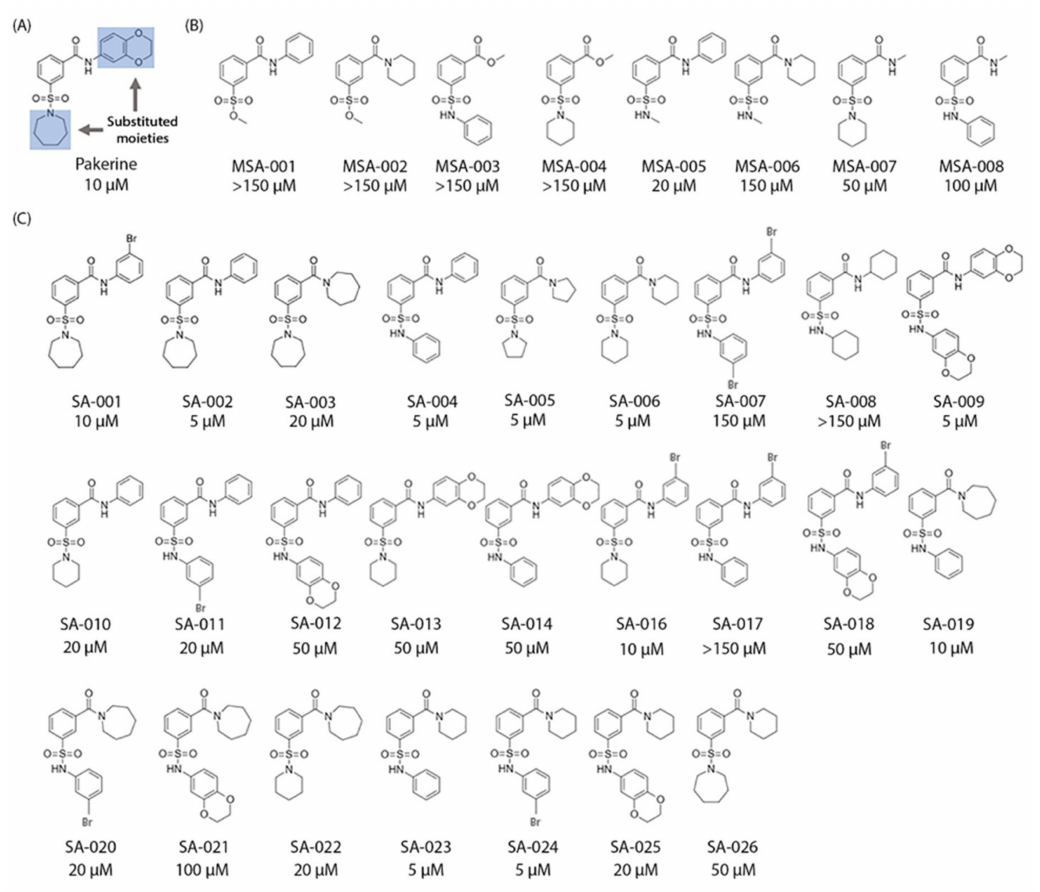
Figure 6. Structure–activity relationship (SAR) analysis of pakerine. ( A ) Original chemical structure of pakerine. Functional groups that were modified in the synthesized analogues are highlighted in blue. ( B ) Analogues with single substitution in the original structure. ( C ) Analogues with two substitutions in the original structure. The active concentrations at which the analogues attenuated F v ’ / F m ’ decline in cat2-2 mutants exposed to photorespiratory stress are shown below each